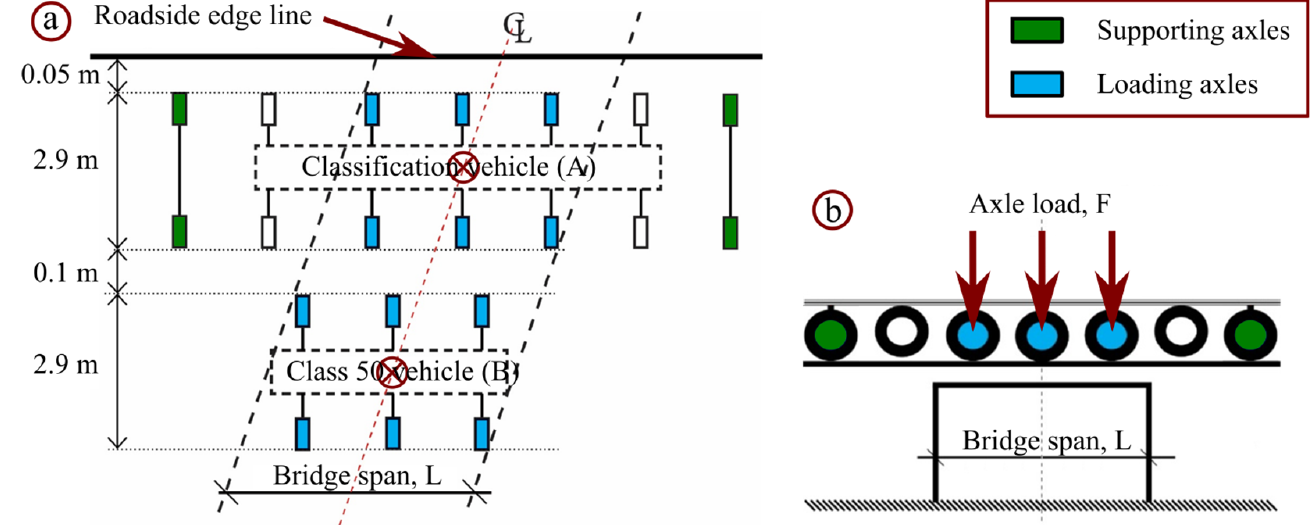
Figure 4. Load placing and application: ( a ) placing of vehicle A (the classification vehicle) and vehicle B (a class 50 vehicle), and ( b ) loading and supporting axles.